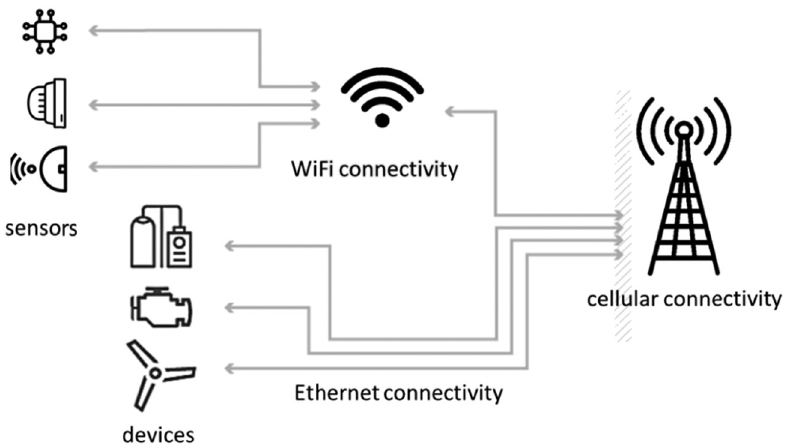
Figure 2: The data acquisition of the IoT